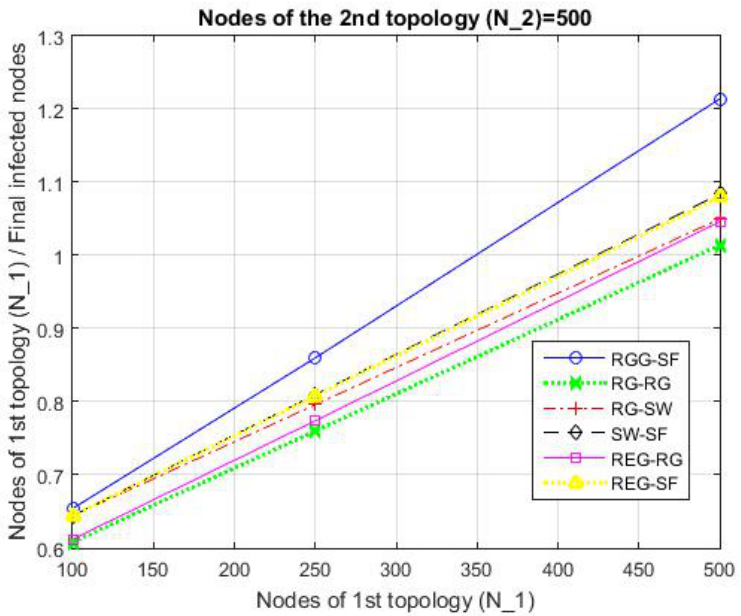
Figure 13. Spread of malware while the nodes of the 2nd topology remain equal to N_1 = 500.